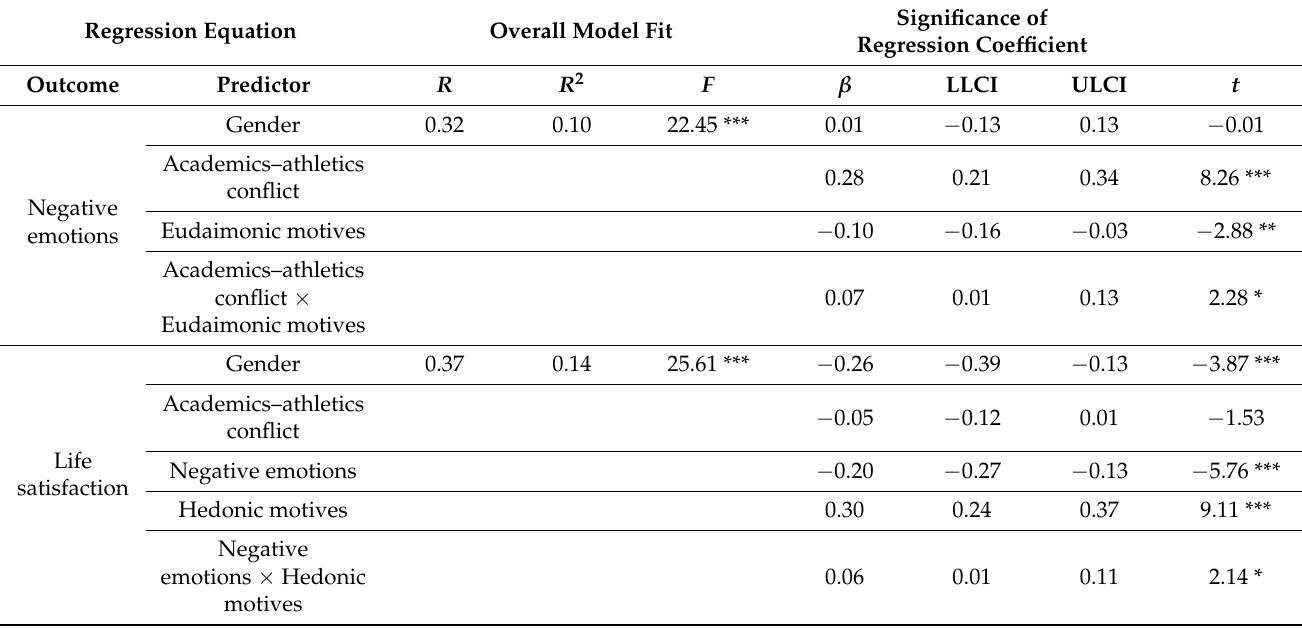
Table 3. Regression analysis results of moderated mediating effect.